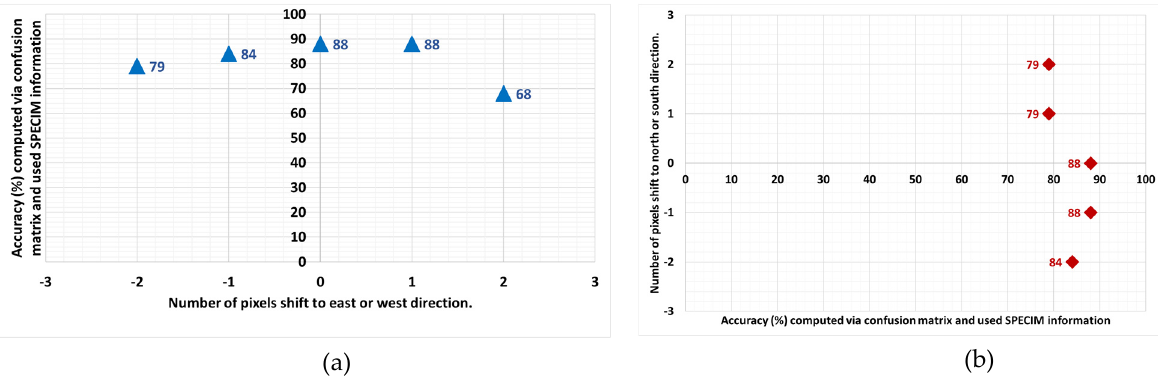
Figure 7. The ASTER mineral map’s accuracy by shifting 1 − 2 pixels in ( a ) east-west and ( b ) north-south directions. Minus values demonstrate ( a ) west and ( b ) south directions while positive values demonstrate ( a ) east and ( b ) north. Zero is the ASTER classified mineral map without any displacement and pixel shifting.